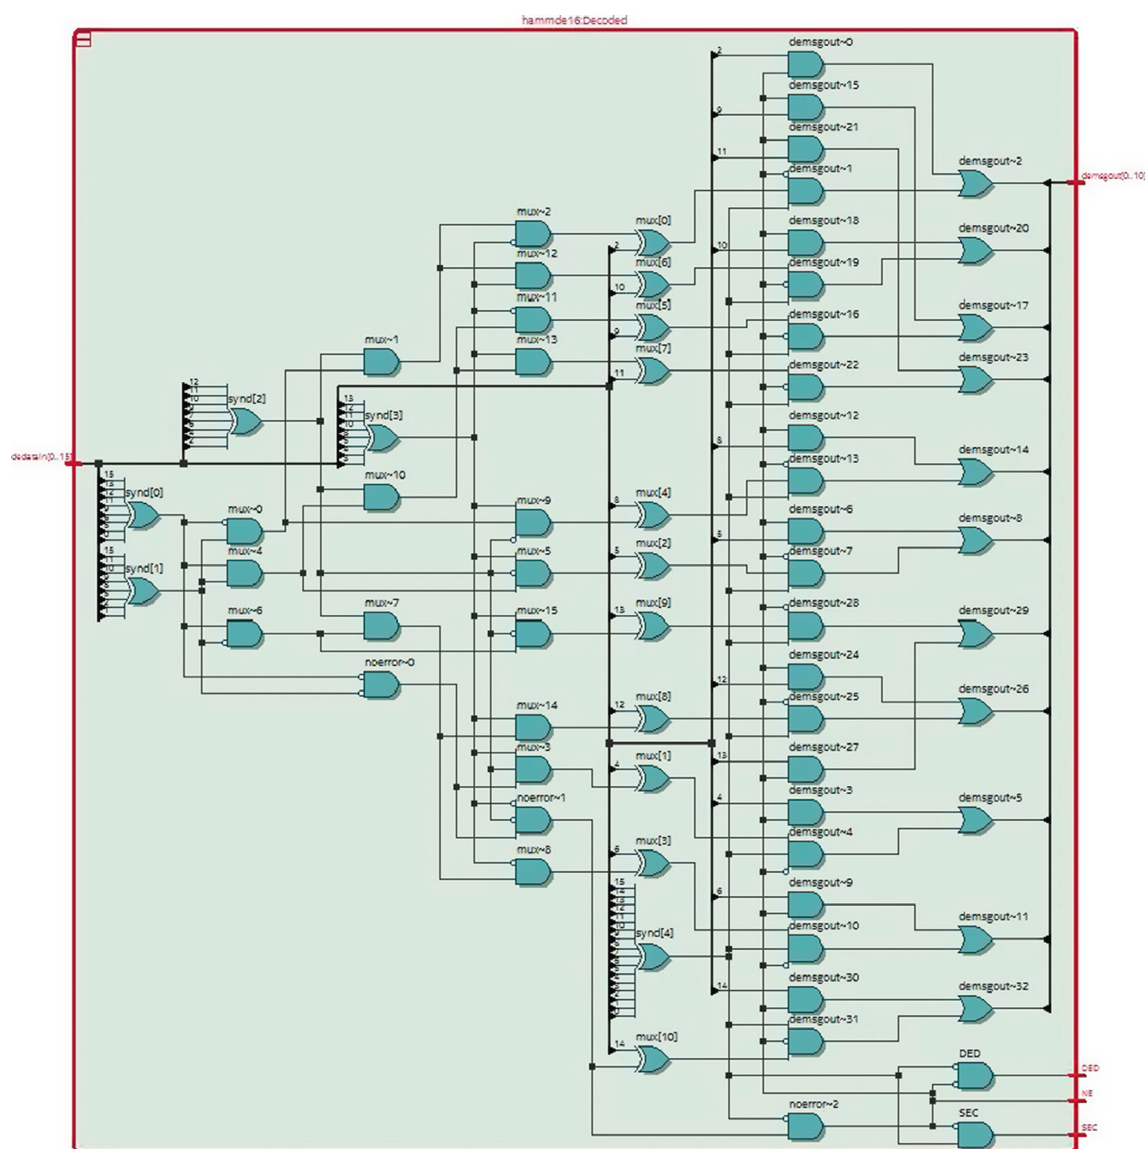
Figure 13: RTL overview of the optimized decoder for Hamming [16, 11, 4]